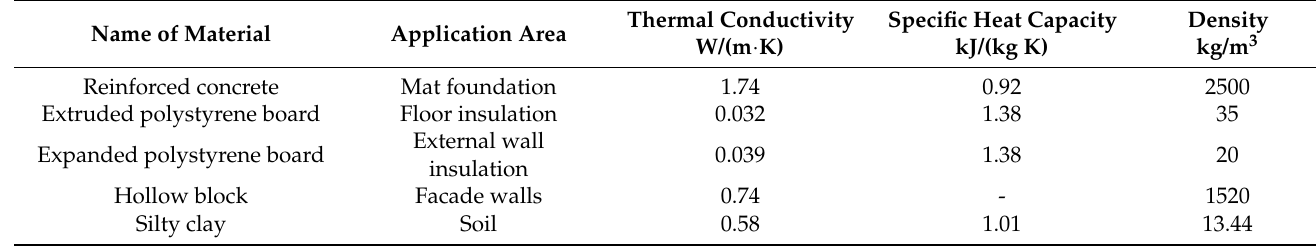
Table 2. Thermophysical properties of